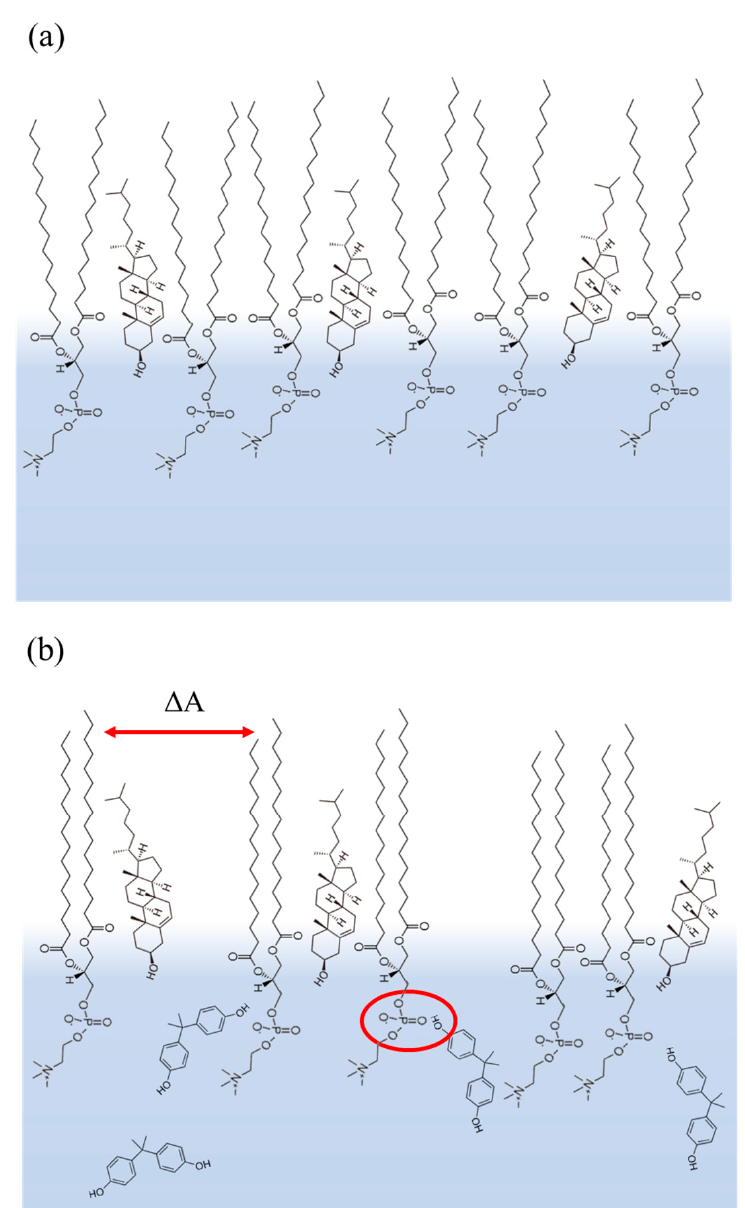
Figure 6. Monolayer structuring of DPPC/Chol (3:1) mixture at 30 mN/m in the ( a ) absence and ( b ) presence of BPA. The red circle indicates the possible interaction between the lipids and BPA.